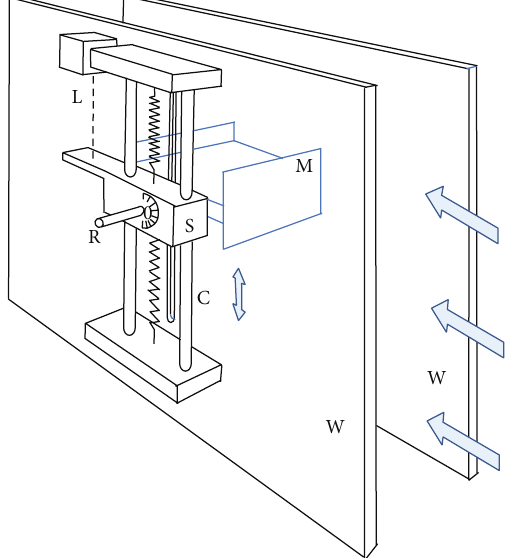
Figure 3: General view of the dynamic test device. Wind tunnel walls (W), model (M), rod (R), sliding support (S), columns (C), and laser displacement sensor